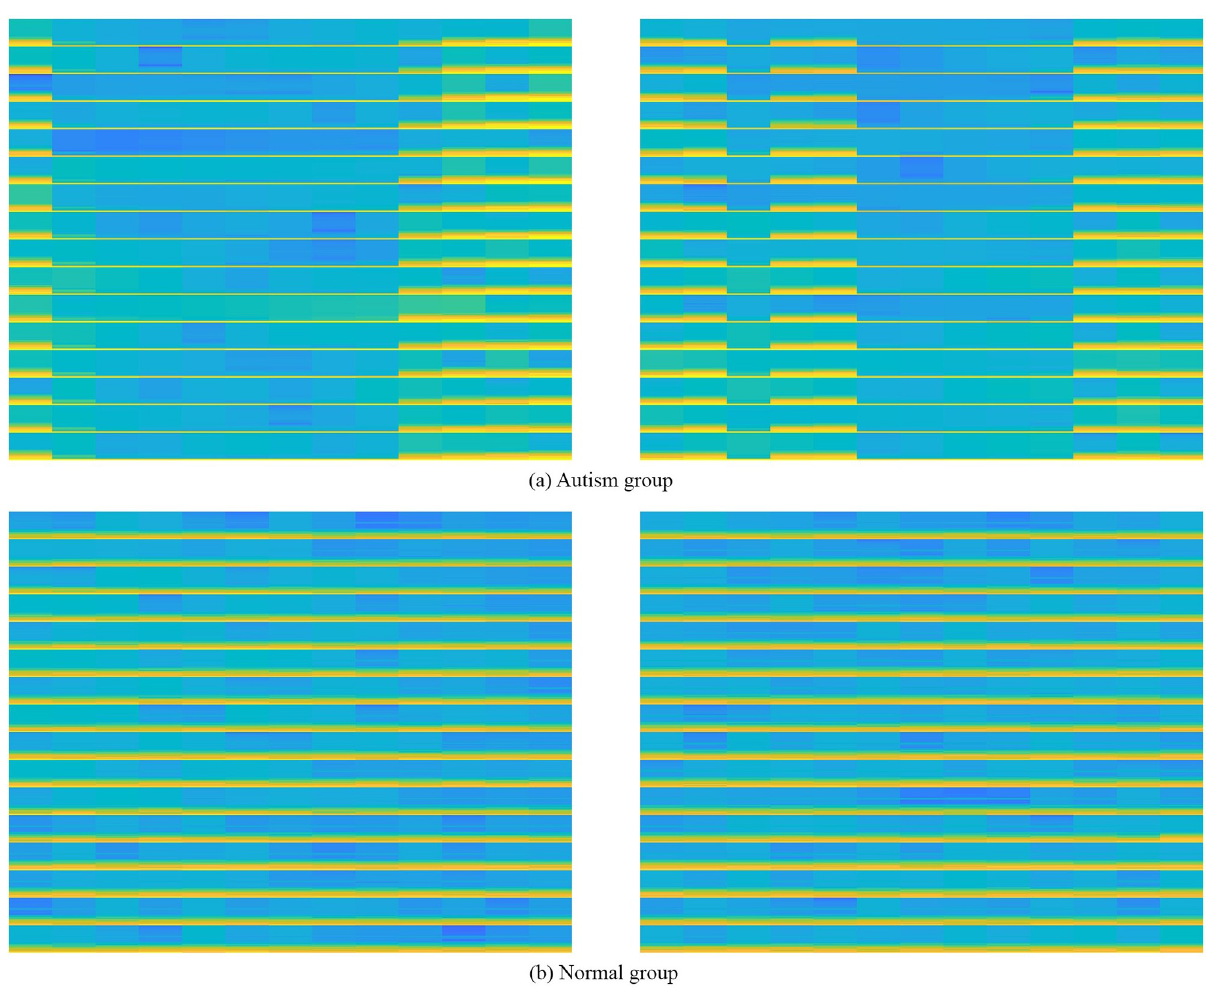
Fig 6. Sample spectrogram images. (a) Images from ASD group, (b) Images from non ASD subjects.